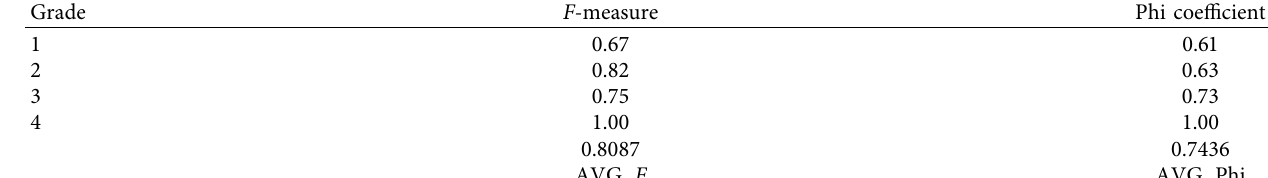
Table 7: Performance evaluation results of the decision tree